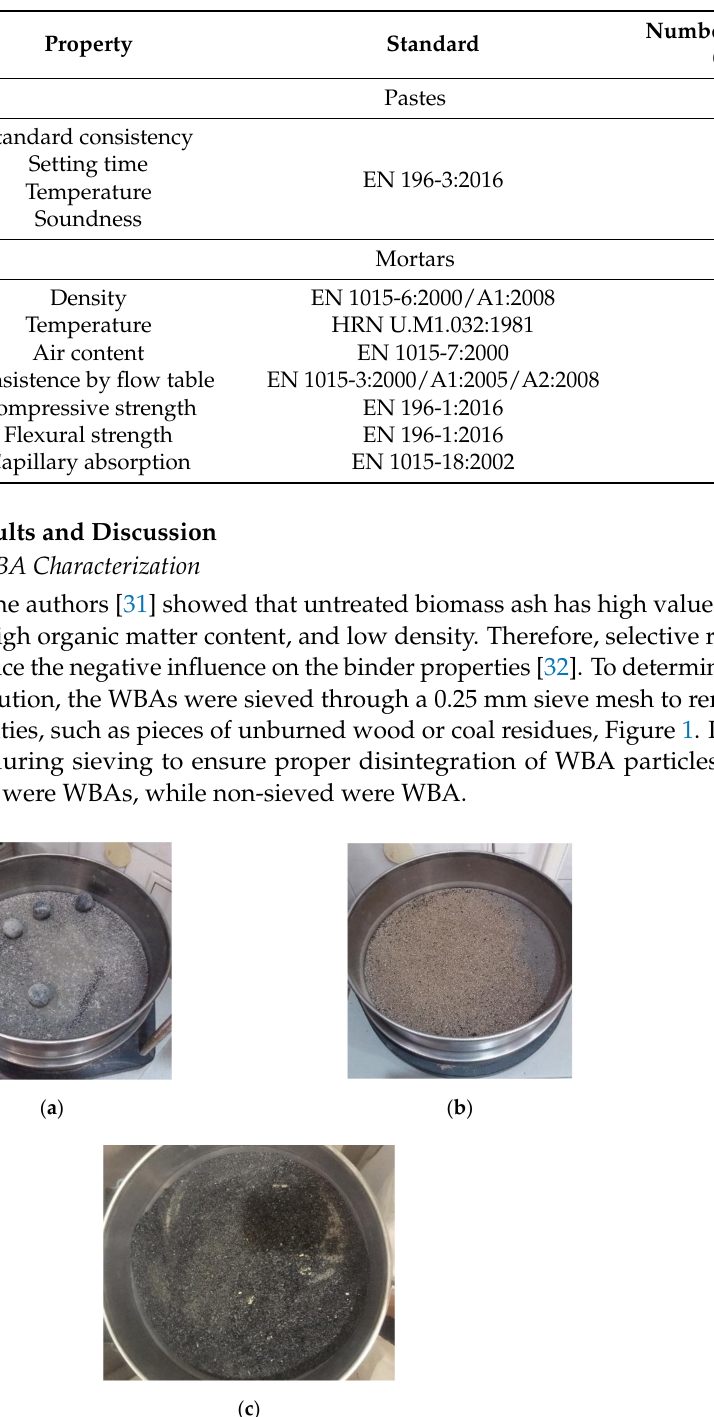
Table 4. Test methods for characterization of paste and mortar properties.